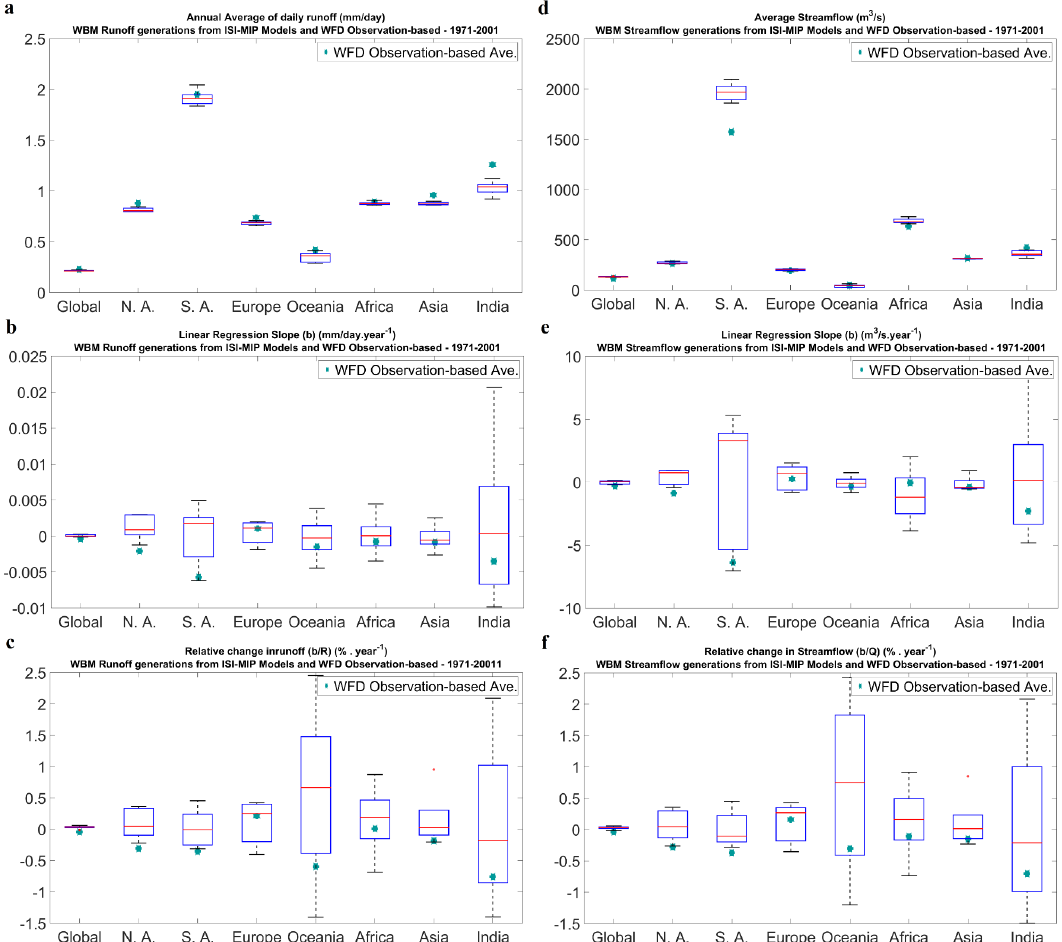
Figure 5. Boxplots of runoff and streamflow trends simulated under climate forcings from either ISI-MIP models (minimum, 25th percentile, median, 75th percentile and maximum of the 5 model runs) or WFD observation-based data (shown as blue circles) for 1971–2001 on global and continental scale—( a ) annual average of runoff (mm·day − 1 ), ( b ) linear regression slope of change in annual-averaged runoff (mm·day − 1 ·year − 1 ), ( c ) relative change in annual-averaged runoff (%·year − 1 ), ( d ) average of discharge (m 3 ·s − 1 ), ( e ) linear regression slope of change in discharge (m 3 ·s − 1 ·year − 1 ), ( f ) relative change in discharge (%·year − 1 ).